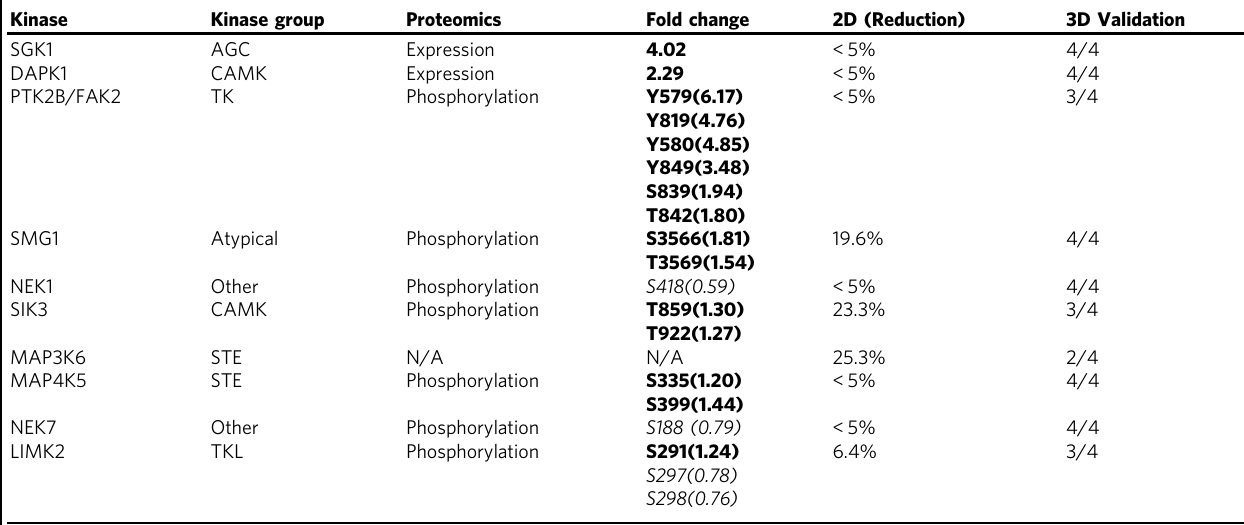
The table lists kinases that markedly perturbed the Src-induced transformed phenotype in 3D culture and were subsequently validated by deconvolution of the corresponding siRNA SMARTpools. The “ Proteomics ” and “ Foldchange ” columnssummarizedatafromthekinomicscreen, indicatingwhetherexpression orphosphorylationchangeswereobserved,the correspondingmagnitude(inbrackets), and the direction, with bold font denoting increased and italic font denoting decreased expression/phosphorylation in MCF-10A_Src cells relative to MCF-10A_Ctrl cells (MS results from Fig. 1a, Supplementary Data 1 and Supplementary Table 1). The “ 2D (Reduction) ” column indicates the reduction in viability upon target knockdown in MCF-10A_Src cells cultured in 2D under – EGF conditions. The “ 3D Validation ” column indicates the number of individual siRNAs from the SMARTpool that perturbed the 3D growth of MCF-10A_Src cells under – EGF conditions. MAP3K6 was included in the functional screen but did not exhibit phosphorylation or expression changes in Src-transformed